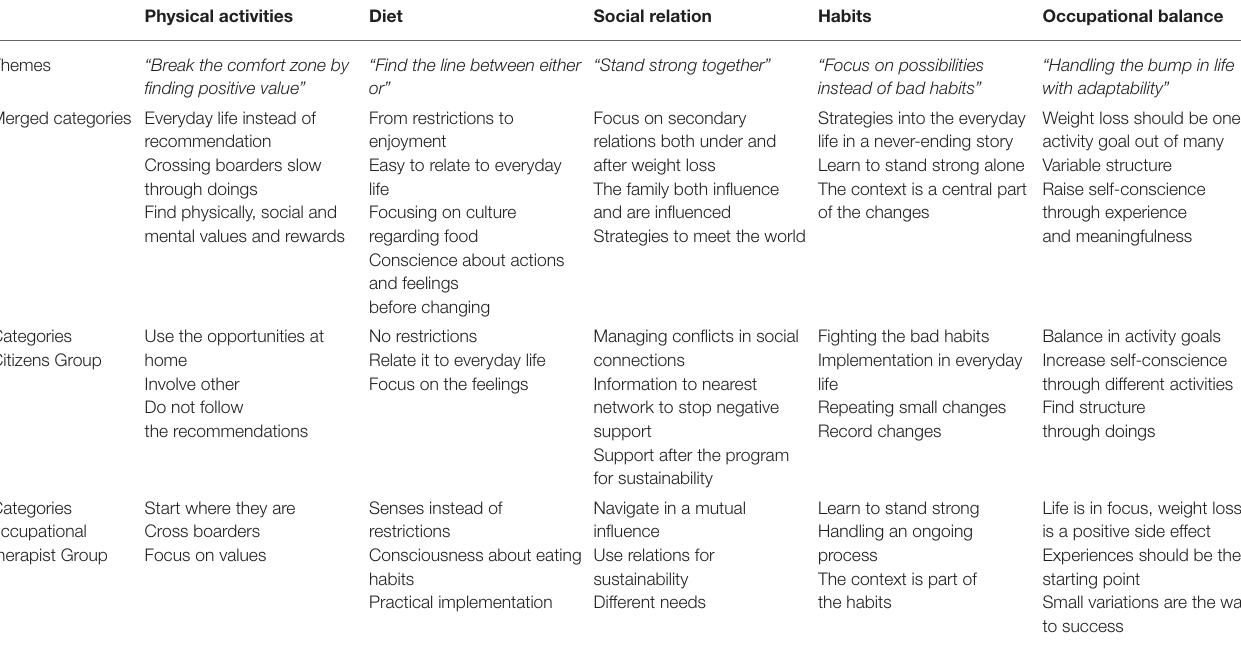
TABLE 2 | Themes and categories.